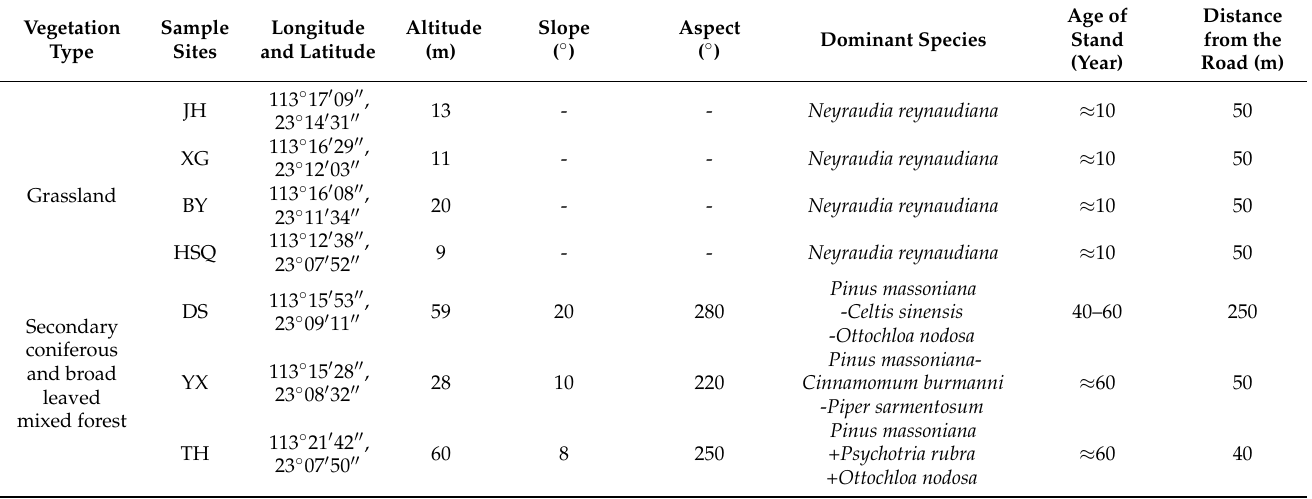
Figure 1. Map of 16 sample sites in different landscape patterns in Guangzhou, southern China. Table 1. Description of 16 sample sites in Guangzhou, southern China.